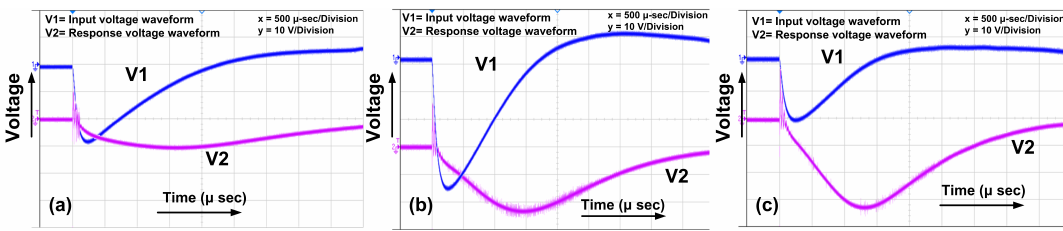
Figure 7. Comparison of the input and response voltage waveforms for the diagnosis of sources of PDs across minor insulation ( a ) Normal case ( b ) PD-1-minor ( c )